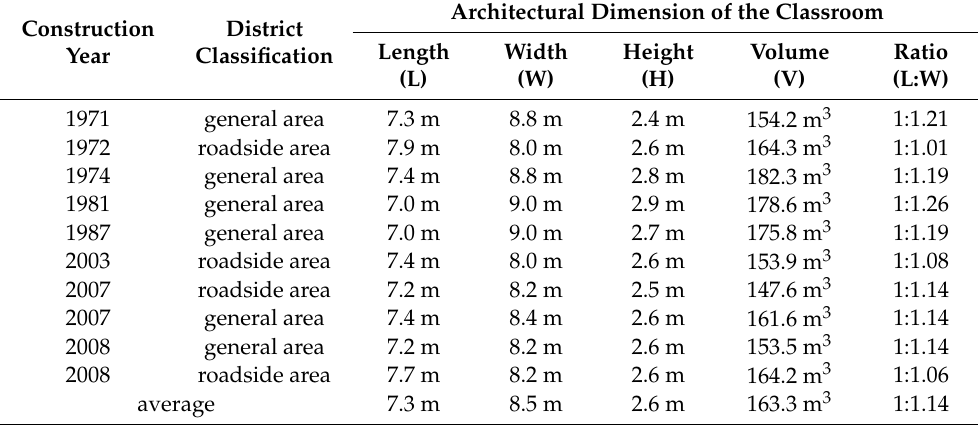
Table 5. Information of the 10 elementary school